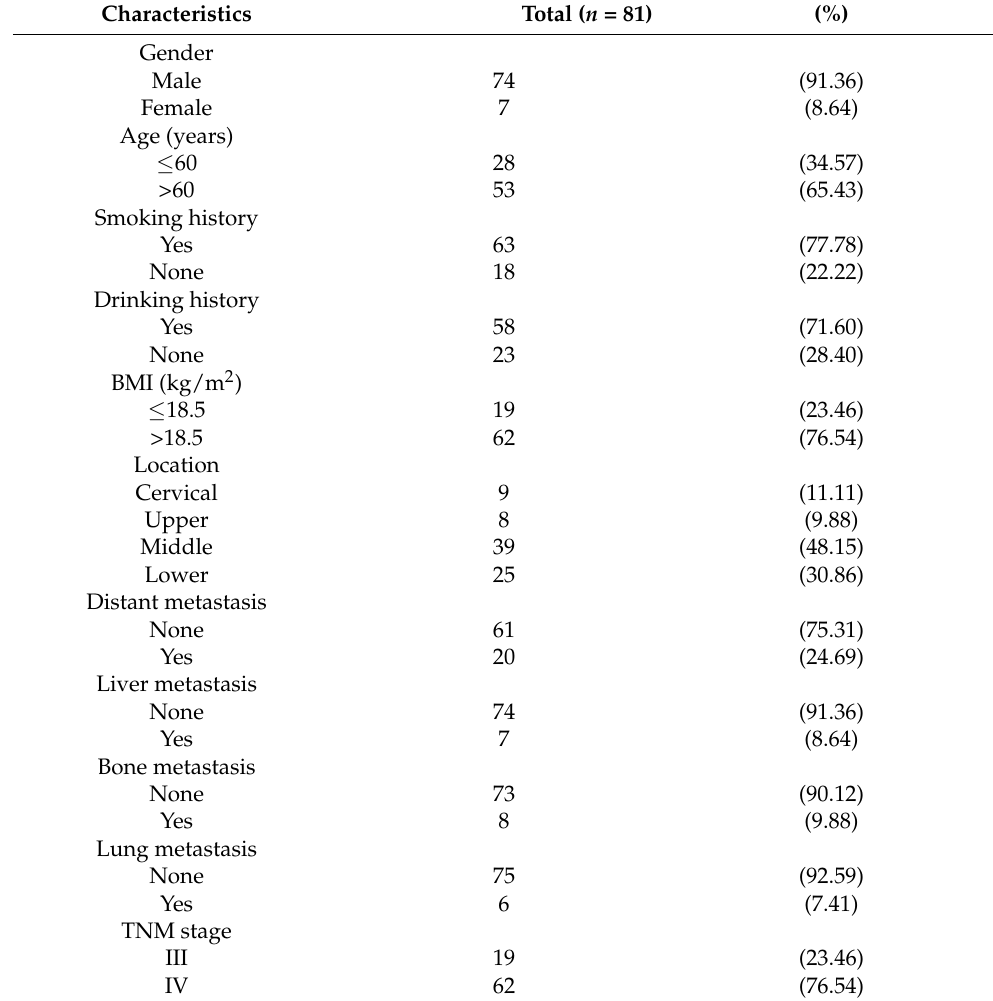
Table 1. Clinical characteristics of patients at